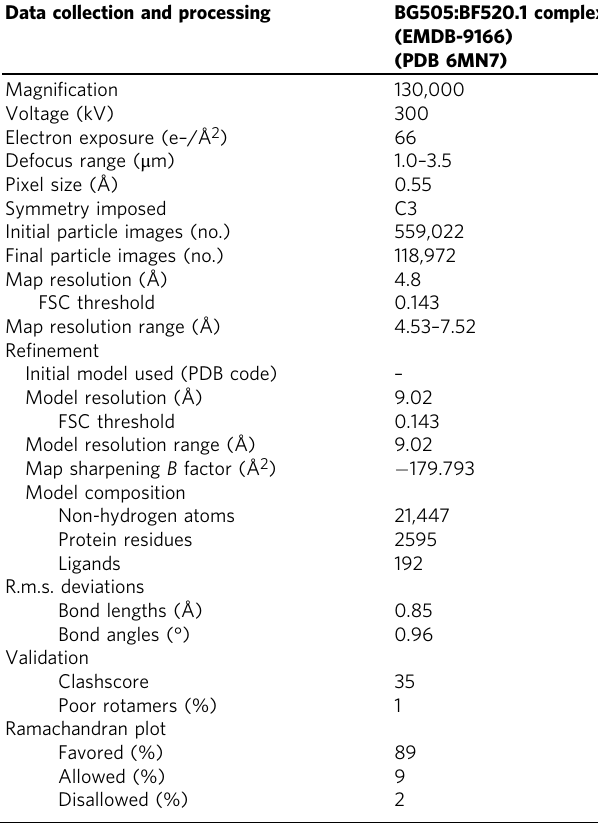
Table 2 Cryo-EM data collection, re fi nement parameters and model